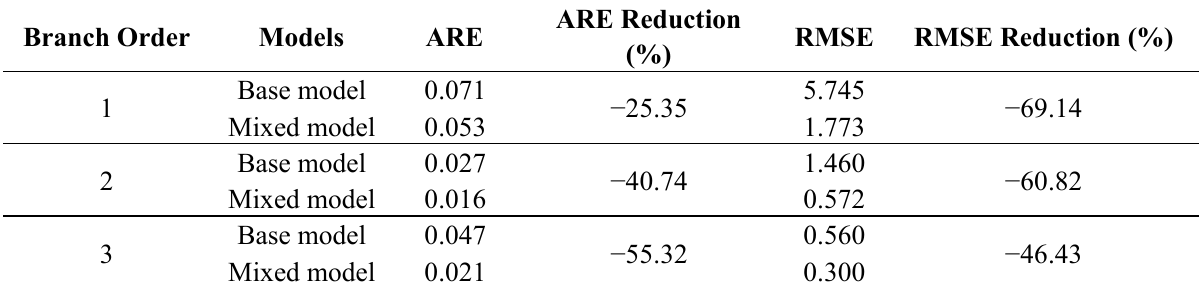
Table 7. Comparison between the base model and mixed model